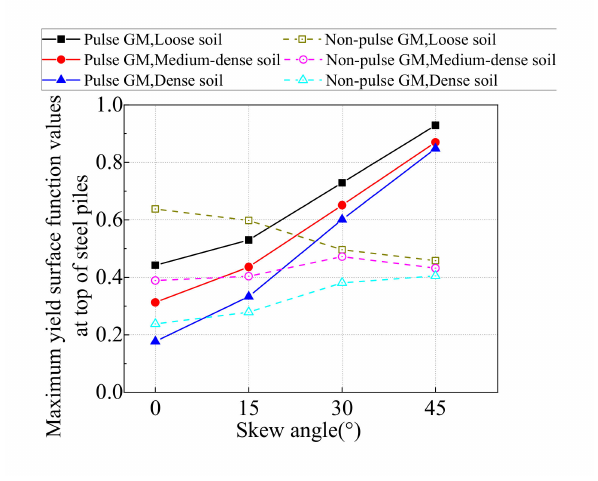
Figure 20. Maximum yield surface function value of the pile